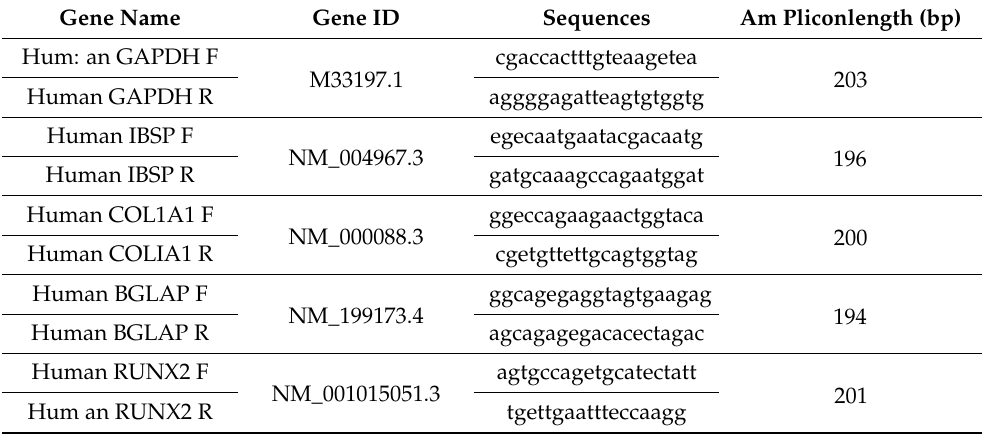
Table 1. RT-PCR primer